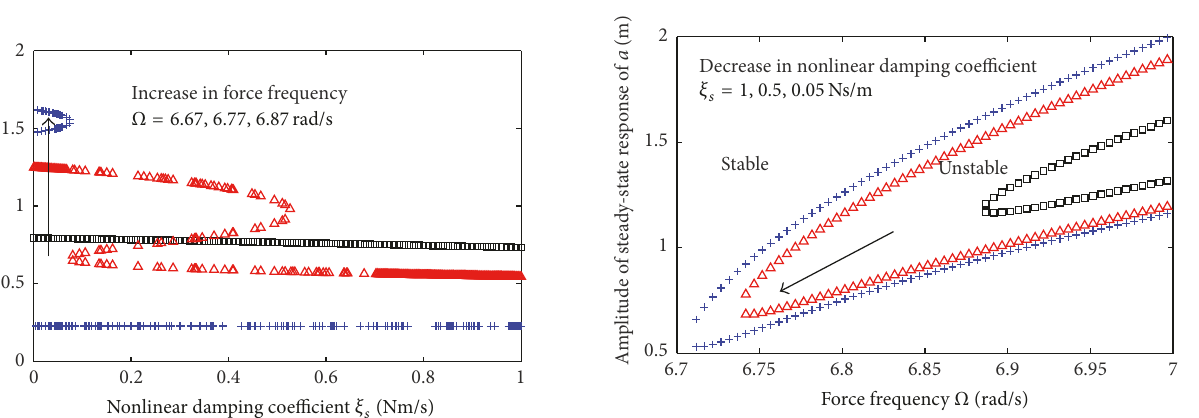
Figure 8: The effect of varying nonlinear damping coefficient 𝜉 𝑠 on unstable area of vibration 𝑎 . 𝜉 𝑠 = 1 Ns / m ( black squares), 𝜉 𝑠 = 0.5 Ns / m (red triangles), and 𝜉 = 0.05 Ns / m (blue 𝑠